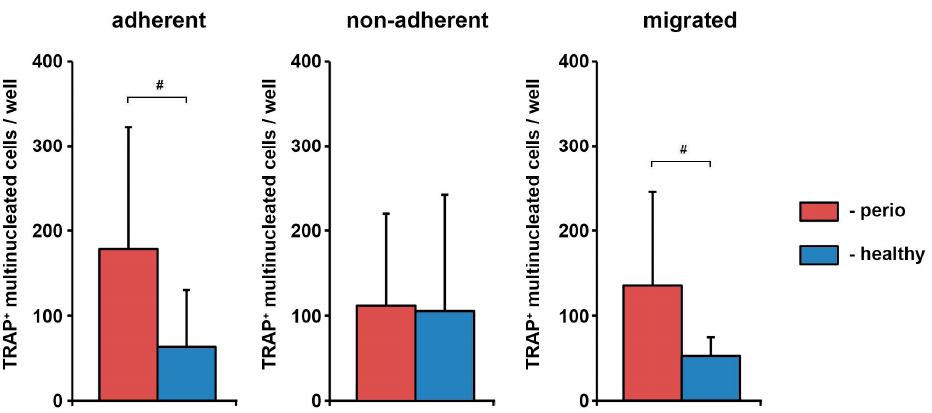
ony stimulating factor and dexamethasone for 21 days and stained with TRAP. Positively stained cells with ≥ 3 nuclei were considered as osteoclasts. The photo has been taken under a microscope (Eclipse TS100, Nikon, Germany) using Optocam-II camera (Optoteam, Germany) at 20× magnification. Scale bar corresponds to 200 µm.